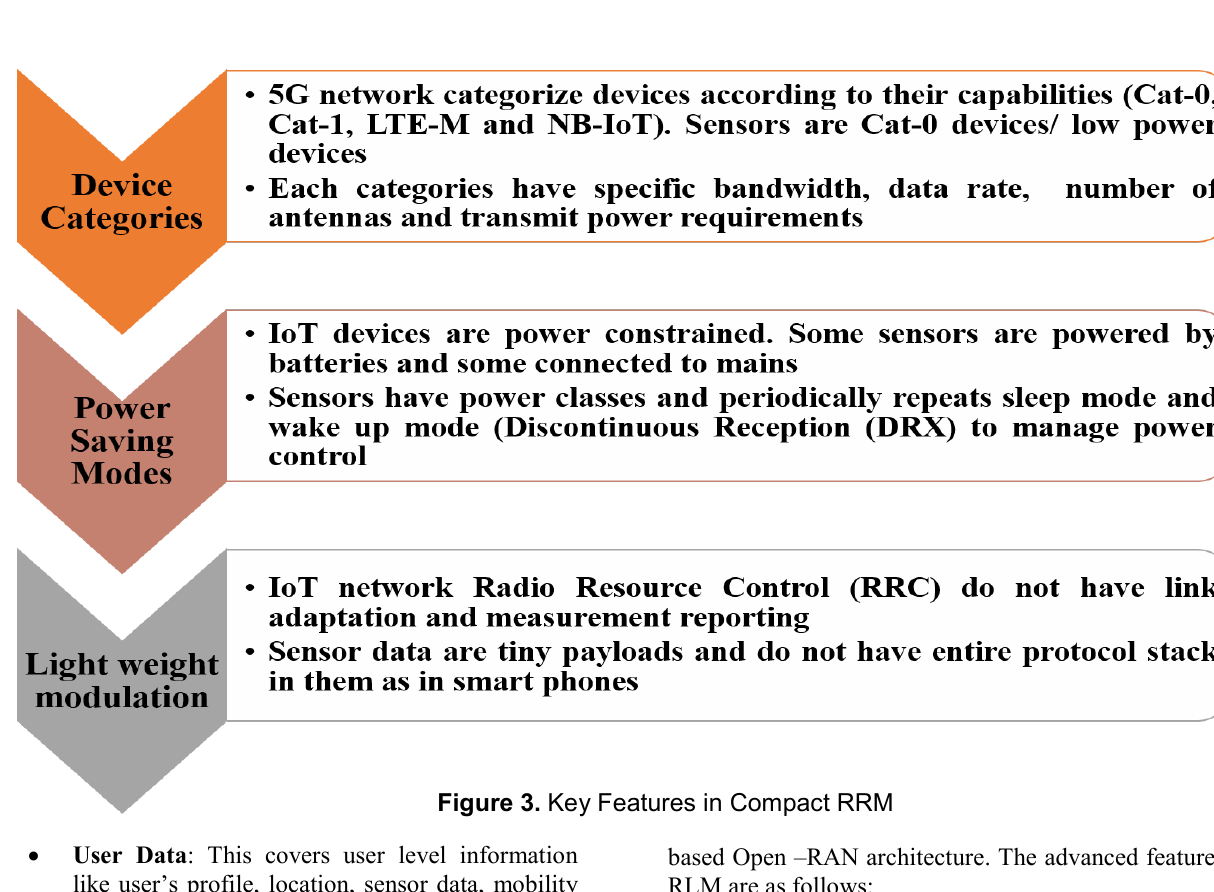
Figure 3. Key Features in Compact